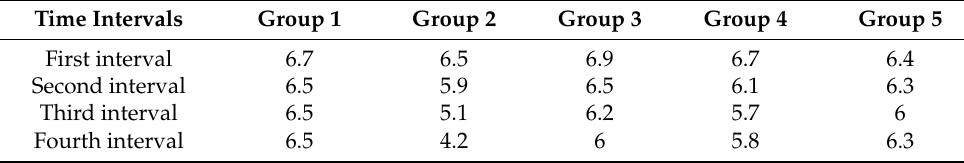
Table 3. Different studied groups regarding the muscle size at different time